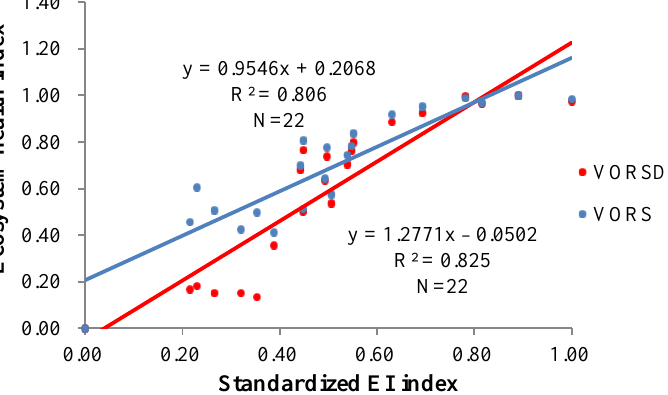
Figure 9. The regional adaptation assessment results for VORS and VORSD models using the standardized EI index.